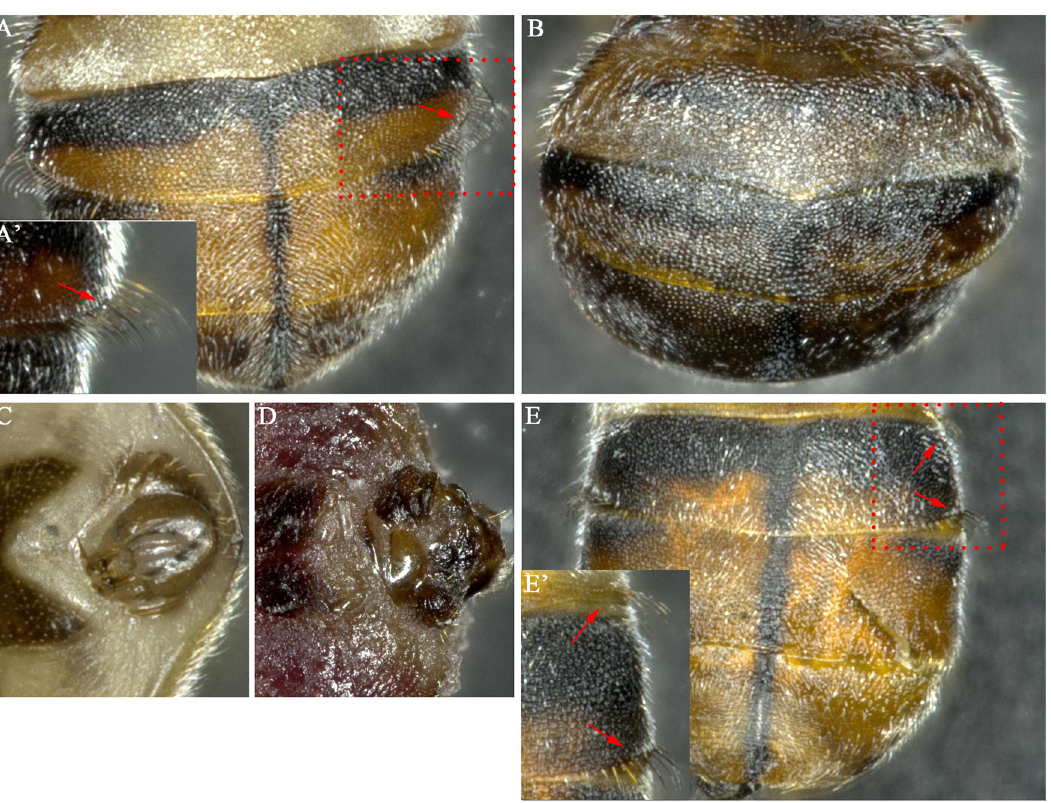
Fig 3. Phenotypes analyses of RNAi intersex individuals. (A) Wild-type male with 25 black short bristles on each lower side of the third tergum, magnification of the red dotted section in A is shown in A ’ ; (B) Intersex individual with male genitalia and female dorsal phenotype without bristles on both sides; (C) Normal male genitalia in XY males; (D) Malformed male genitalia of one intersex individual; (E) One XY male with an excessive row of bristles on the right lower side of the second tergum, magnification of the red dotted section in E was shown in E ’ . A, B, E: dorsal view; C-D: ventral view; arrows indicate the position of bristles.